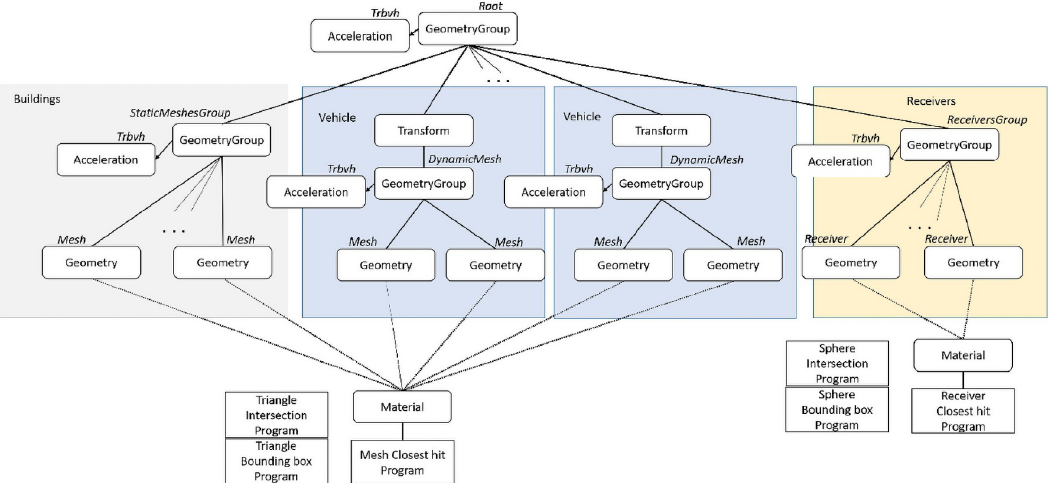
Fig 3. Opal scene graph. There are three groups in the graph: buildings or other static interactive environment elements, vehicles or any other moving interactive elements and receivers, which can be moved but since are made of spheres, do not need transformation